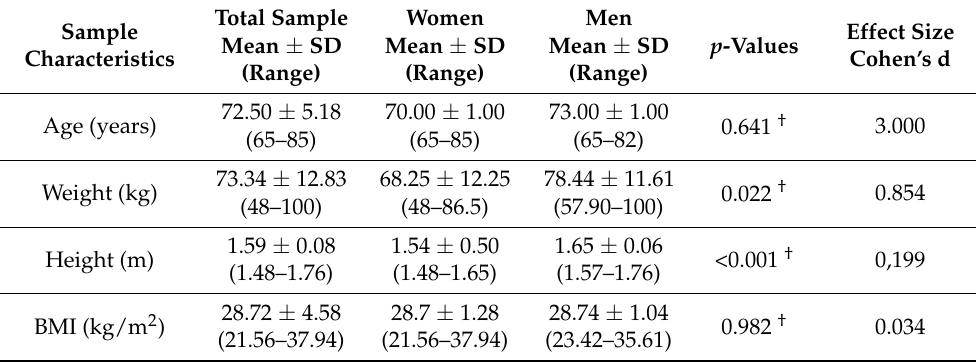
Table 1. Sample demographic and anthropometric characteristics.